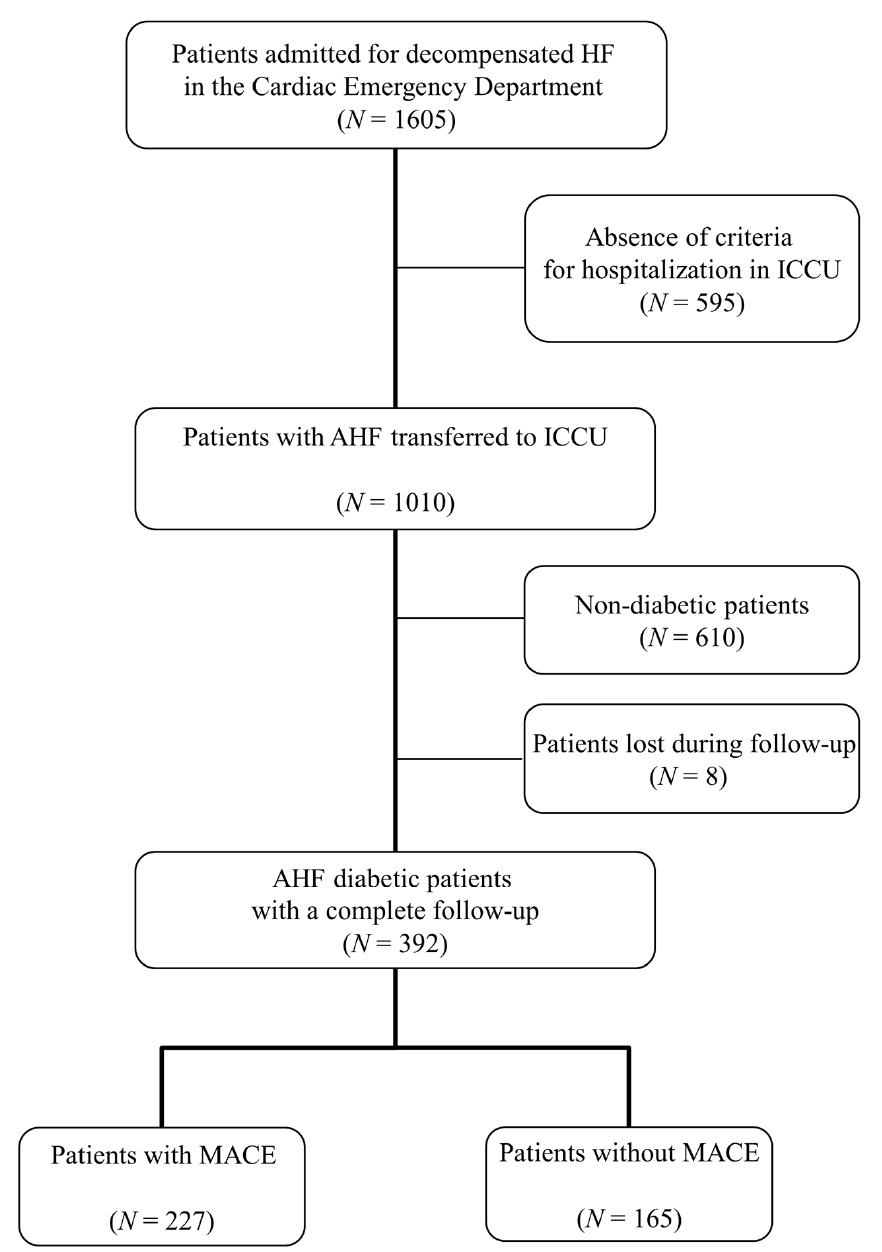
Figure 1. Flowchart of the study. AHF: acute heart failure; ICCU: intensive cardiac care unit; HF: heart failure; MACE: major cardiovascular events. Table 1. Patients’ characteristics and management.